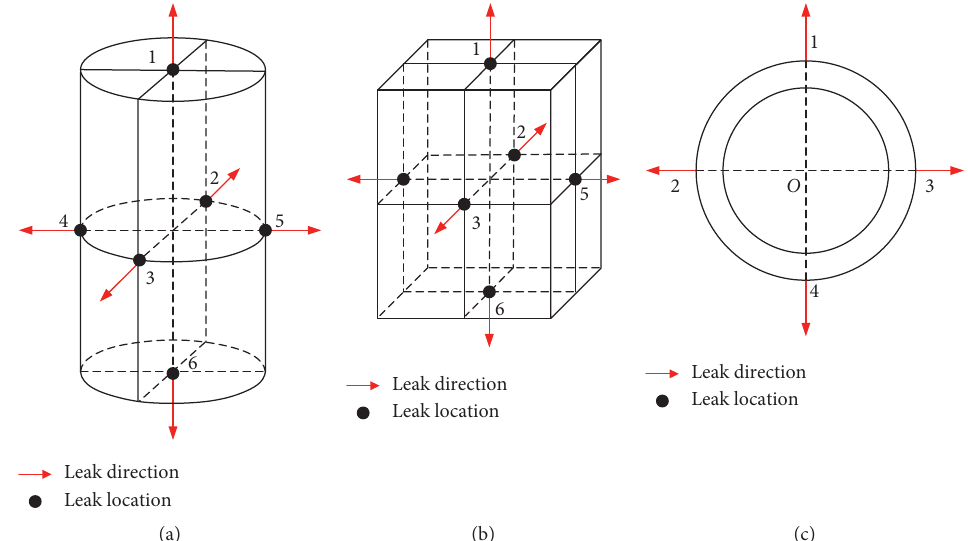
Figure 10: Possible leak location and direction of different equipment.